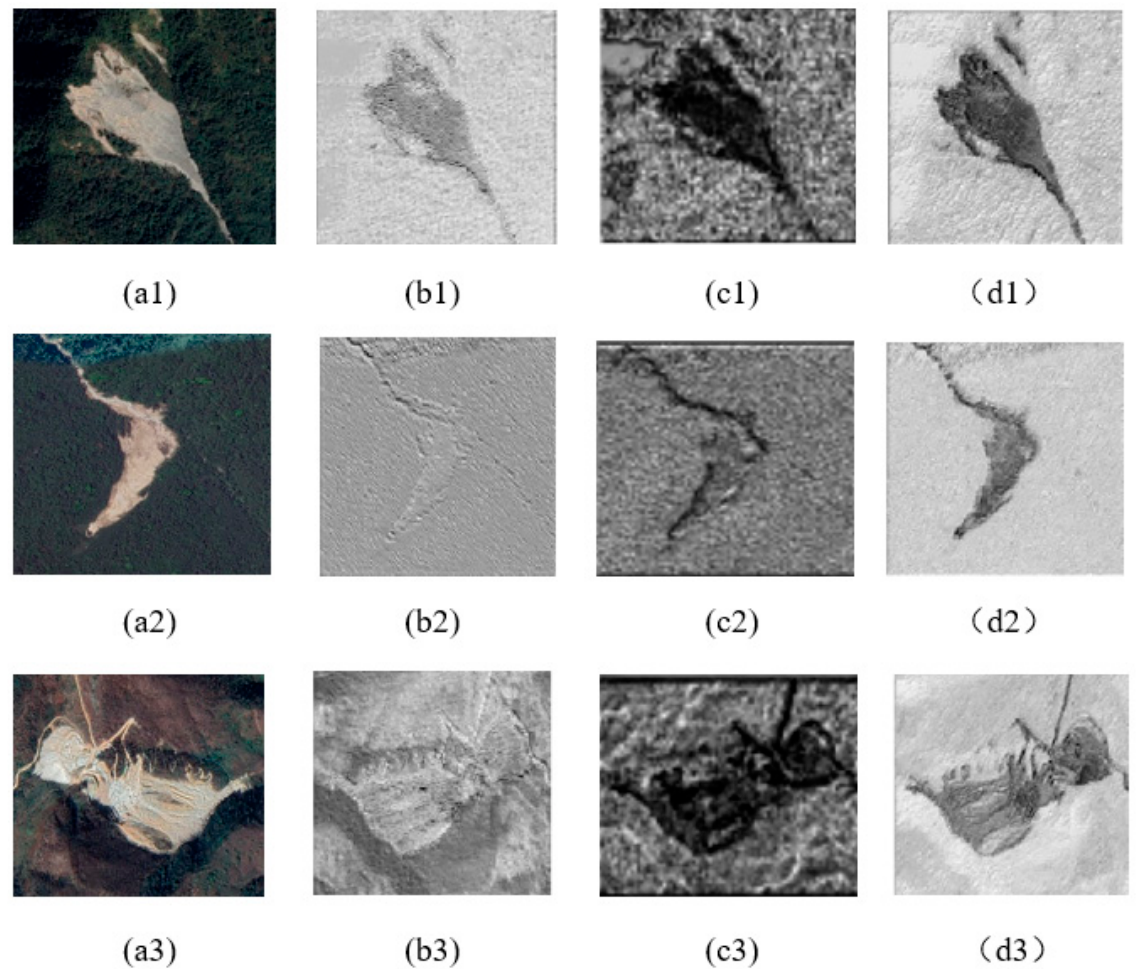
Figure 14. The feature maps. ( a1 – a3 ) are the original landslide images. ( b1 – b3 ) are feature maps of the student network (CBAM-Mini after lightweight feature fusion) in encoding. ( c1 – c3 ) are feature maps of the student network after distillation in decoding. ( d1 – d3 ) are feature maps of the teacher network (Yolov5x) in encoding.